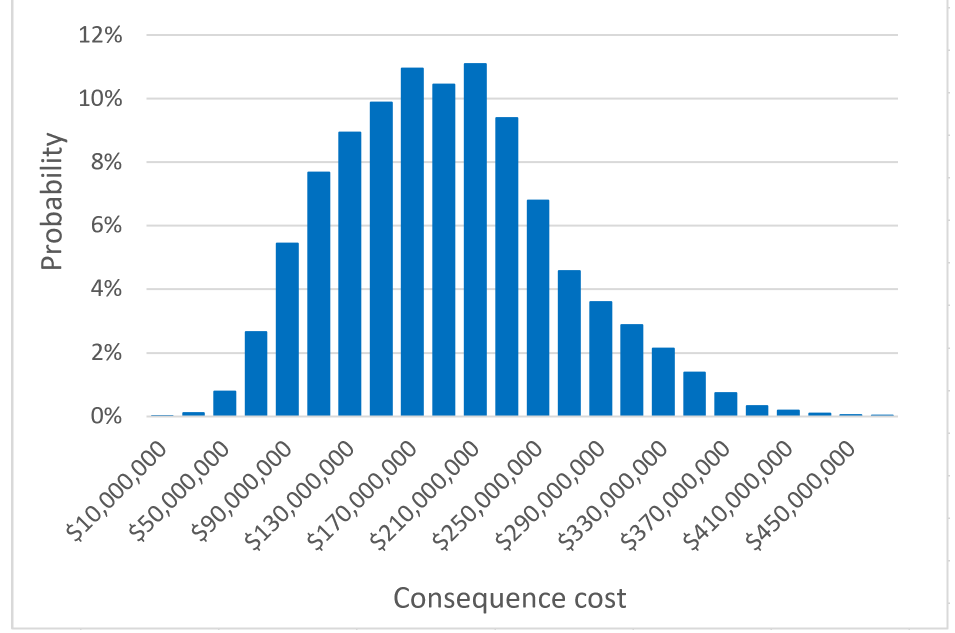
Figure 10. Probability distribution of the outage consequence cost.